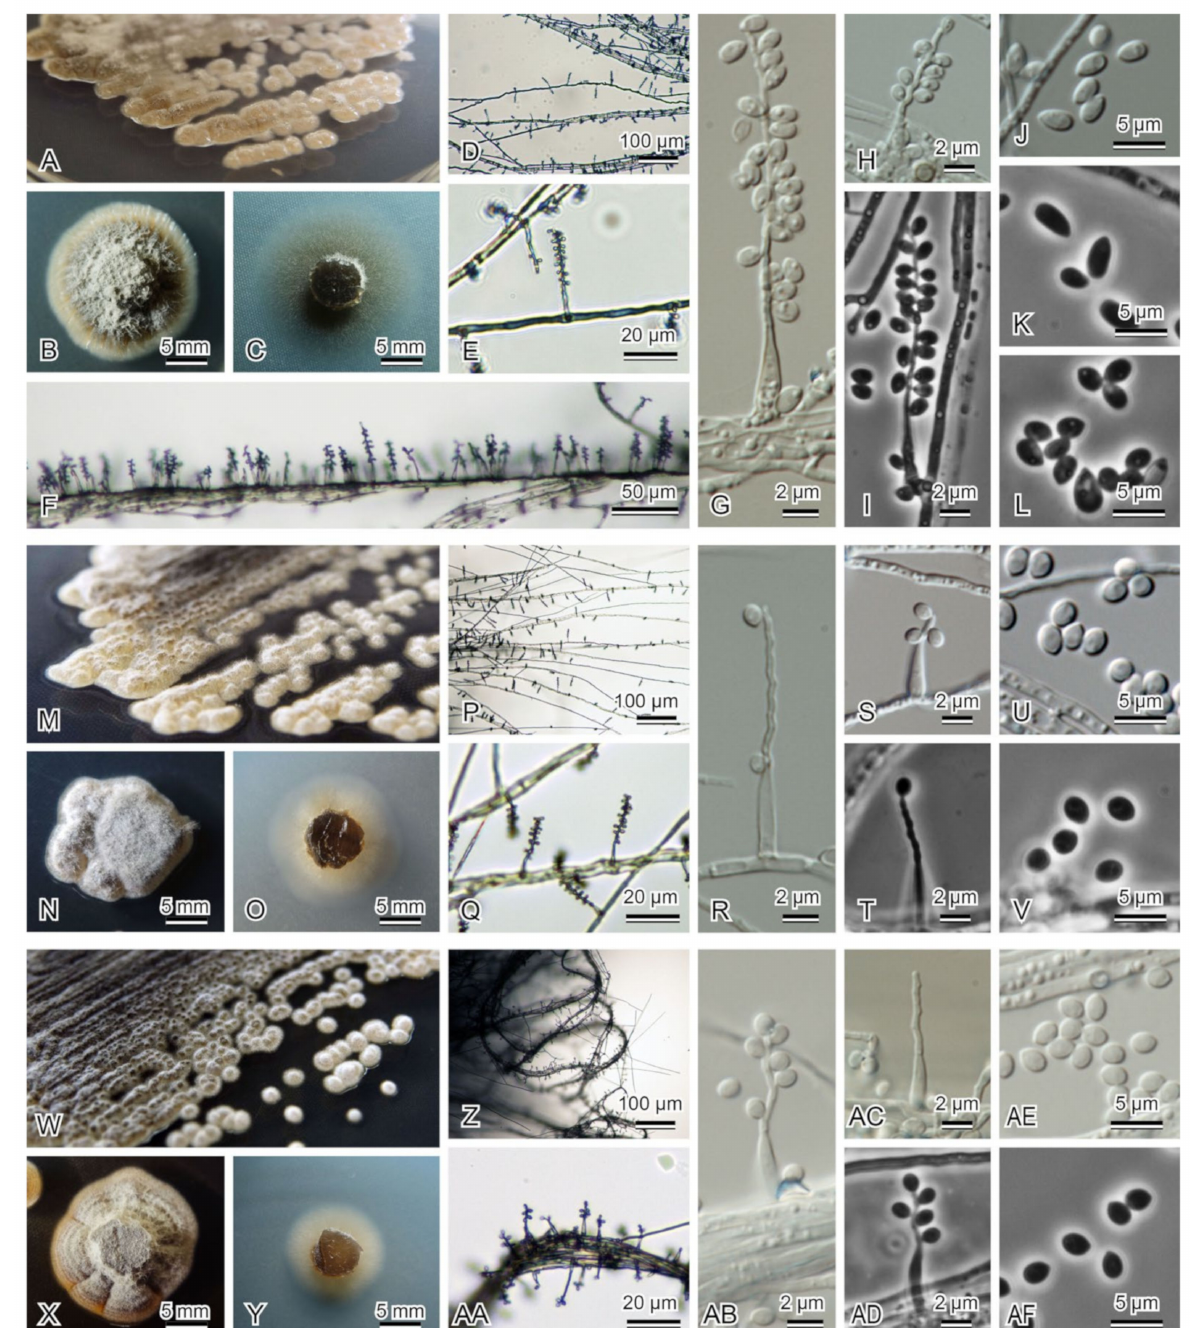
Figure 2. Acrodontium species. ( A – L ) Acrodontium luzulae ( A – C , F , G , H , I , L from JCM 39231; D , E , J , K from JCM 39234). ( A , B ) Colonies on PDA after 8 days at 20 ◦ C. ( C ) Colonies on MEA after 8 days at 20 ◦ C. ( D – F ) Conidiogenous cells on hyphae. ( G – I ) Conidiogenous cells. ( J – L ) Conidia. ( M – V ) Acrodontium sp. 1 aff. crateriforme (JCM 39224). ( M , N ) Colonies on PDA after 8 days at 20 ◦ C. ( O ) Colonies on MEA after 8 days at 20 ◦ C. ( P , Q ) Conidiogenous cells on hyphae. ( R – T ) Conidiogenous cells. ( U , V ) Conidia. ( W – AF ) Acrodontium sp. 2 aff. crateriforme (JCM 39232). ( W , X ) Colonies on PDA after 8 days at 20 ◦ C. ( Y ) Colonies on MEA after 8 days at 20 ◦ C. ( Z,AA ) Conidiogenous cells on hyphae. ( AB – AD ) Conidiogenous cells. ( AE , AF )